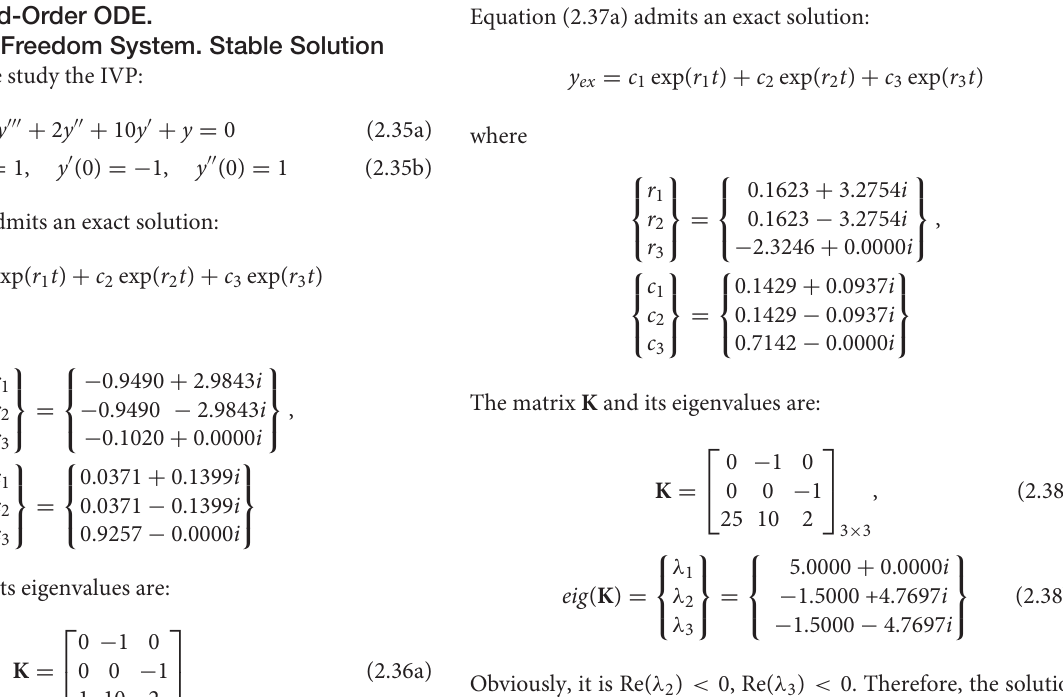
FIGURE 2 | Solution and error in Example 2. Example 4. Third-Order